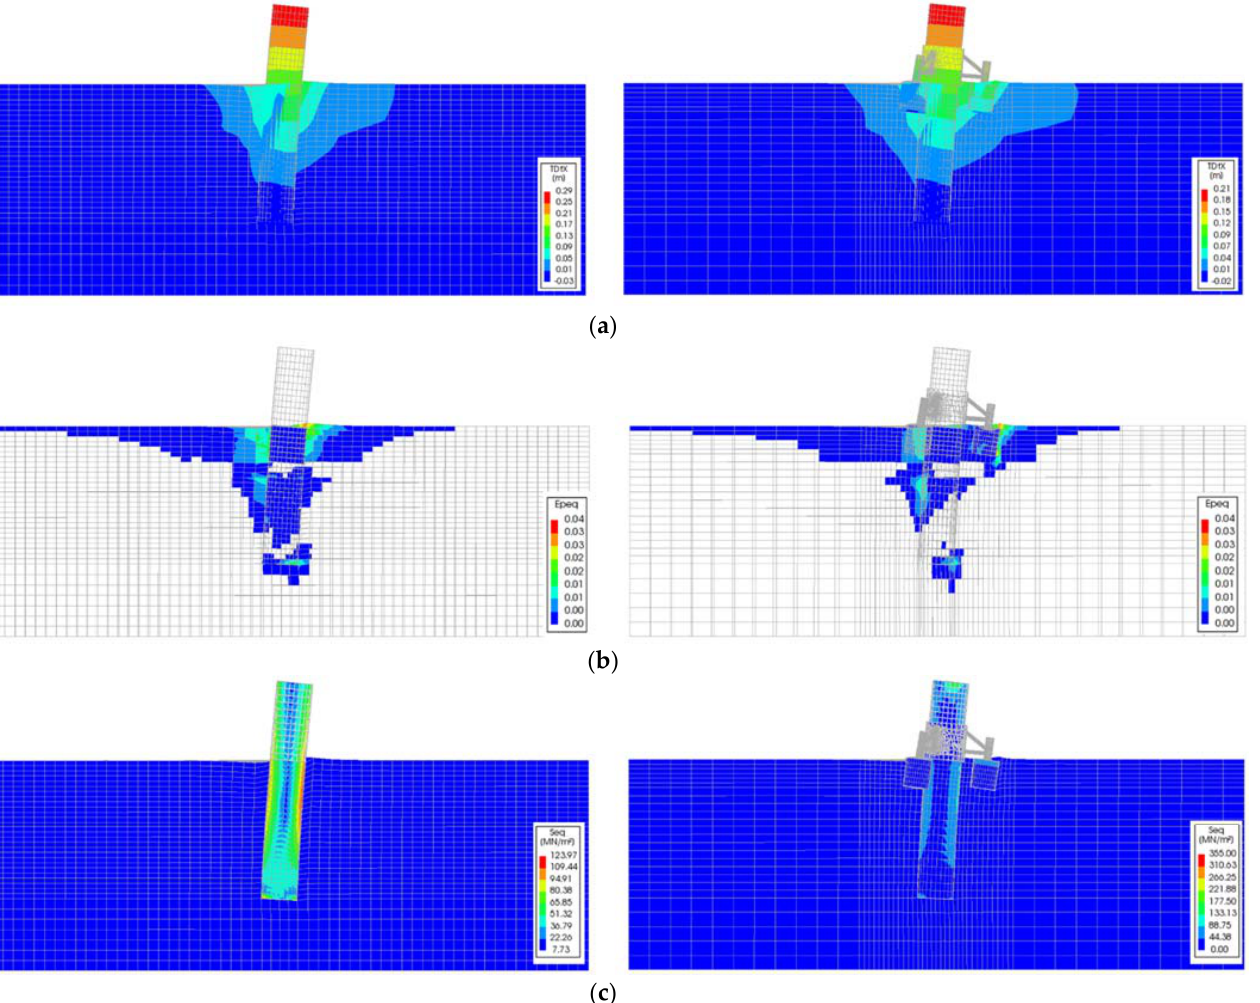
Figure 15. Comparison with results of monopile and hybrid monopile for case B: ( a ) lateral displace- ment; ( b ) equivalent plastic strain; ( c ) von Mises equivalent stress.